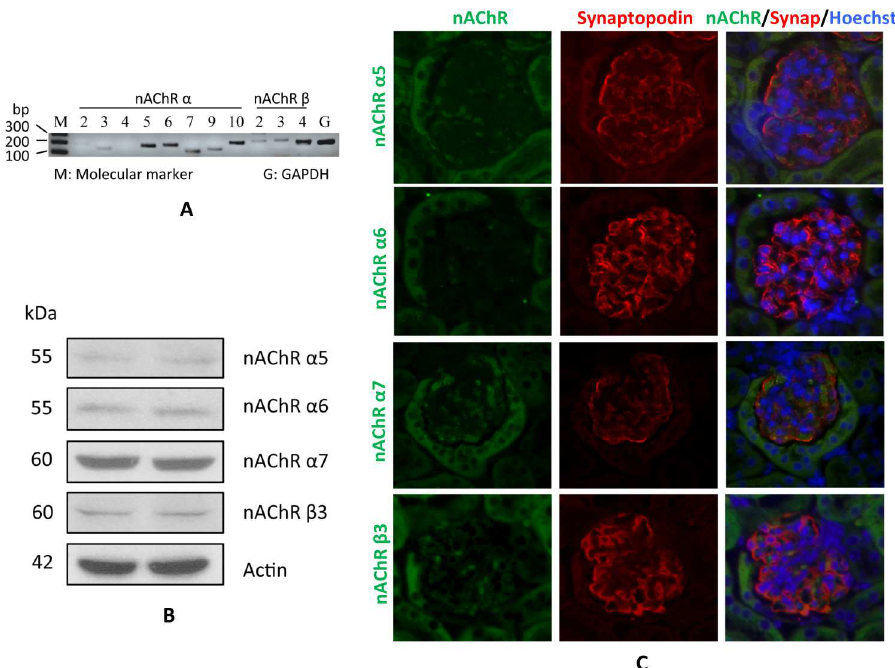
Fig 1. Nicotine receptorsubunits (nAChRs) are expressedin podocytes. A. Total RNAs were prepared from differentiatedhumanpodocytes, and were used for RT-PCR to detect the expressionof nAChR subunits. GAPDH was used as internalcontrol. B. Cell lysate was collectedfrom differentiated human podocytes, and was subjectedto Western blotting to detect the expressionof nAChRs. C. Paraffin sections were preparedfrom 2-month-oldmice kidneys,and immunofluorescencestaining was performed to detect the expressionof nAChRsubunits. Synaptopodinwas used as a marker of podocytes.